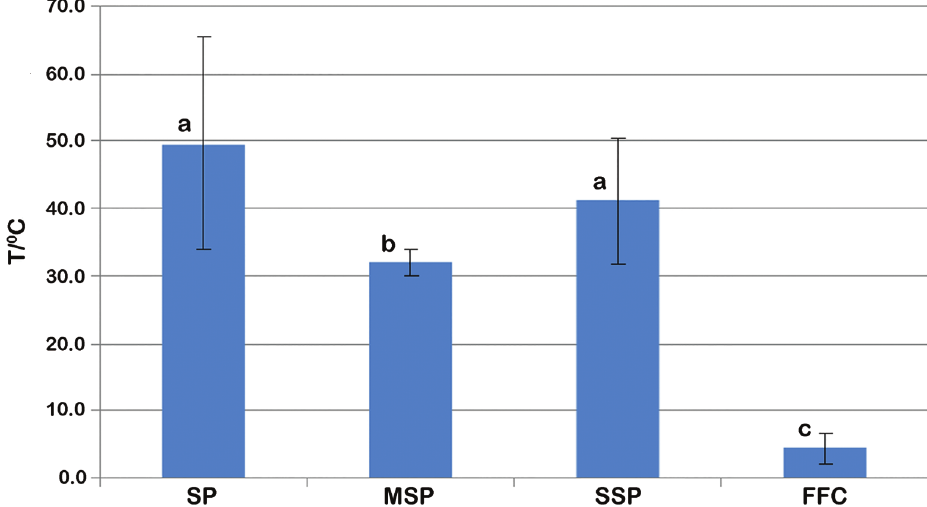
Figure 1. Average temperature (°C) and standard deviations for FFC, SP, MSP, and SSP groups. The temperatures were signi fi cantly higher in the SSP, MSP, and SP groups compared to temperatures in the FFC group (P o 0.001). Temperature in the MSP group was signi fi cantly lower compared to SP (P o 0.001), and SSP (P=0.002) groups. FFC: fl uorescence feedback controlled; SP: short pulse; MSP: medium short pulse; SSP: super short pulse. Different letters indicate a statistically signi fi cant